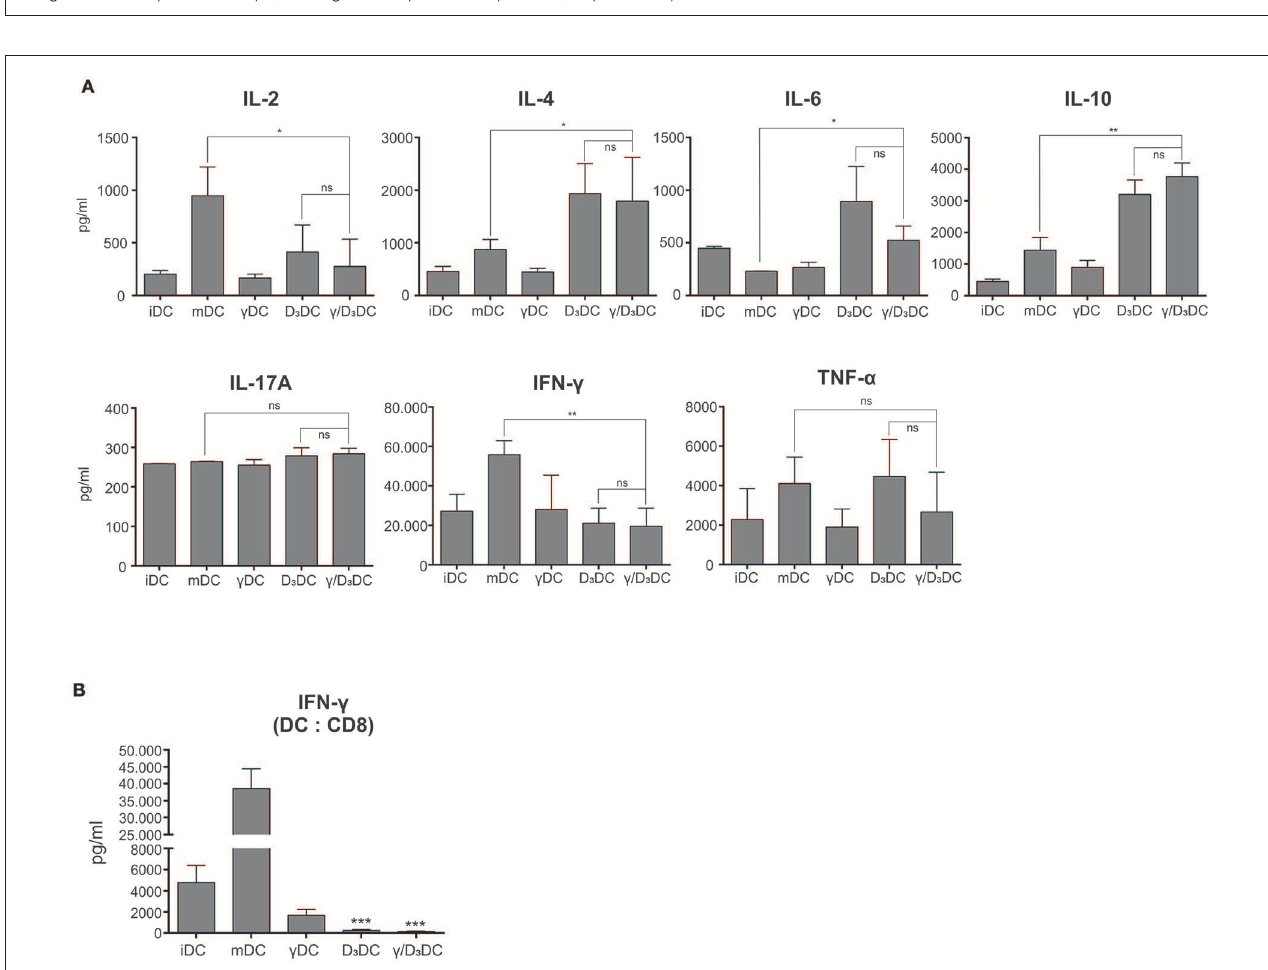
FIGURE 3 | counting. The results are expressed as mean ± SD of counts per minute (cpm) of four independent experiments. (D) Variously treated DCs were stained for surface expression of CD40, CD80, CD83, CD86, HLA class I, and HLA class II molecules. Numbers on histograms represent MFI values. Shown is one representative out of three independent experiments performed. (E) Dendritic cells were treated with vit D 3 or vit D 3 + IFN- γ , followed by 24h activation using LPS or left inactivated. Subsequently they were used as stimulators in an allogeneic co-culture with CD4 + T cells. Proliferation was measured by liquid scintillation counting on day 5, as described above. Immature DCs and DCs matured with LPS + IFN- γ were used as controls. Statistical analysis between individual pairs was performed using Student’s unpaired t -test (ns, non-significant; * p < 0.05; ** p < 0.01; *** p < 0.001).